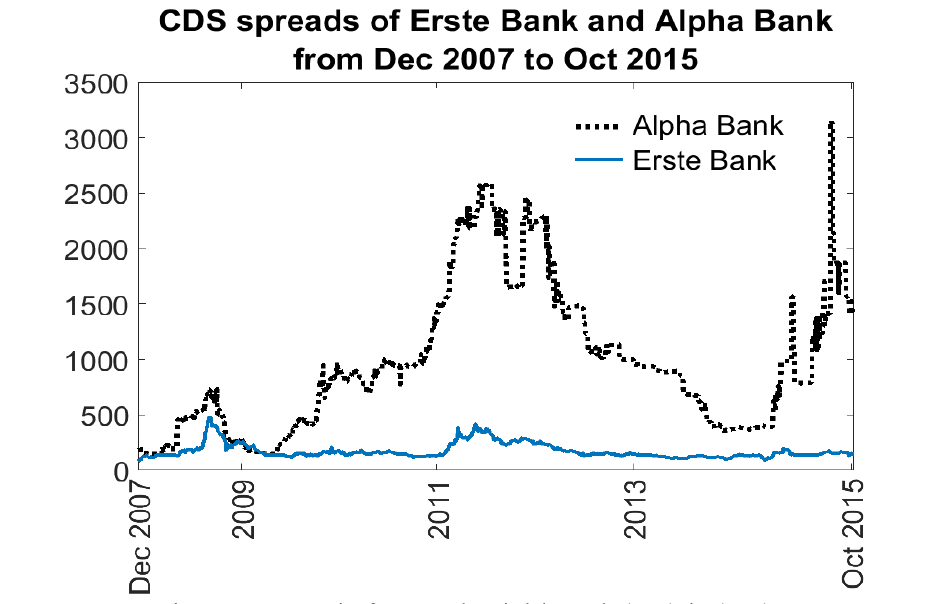
Figure 7: CDS spreads of Erste Bank and Alpha Bank given in basis